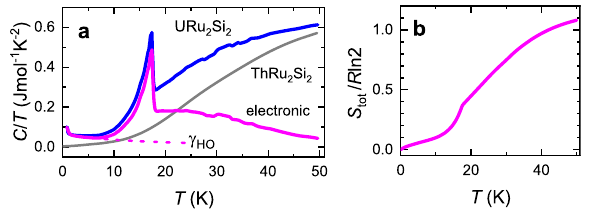
Fig. 2 Heat capacity and entropy of URu 2 Si 2 . a C / T at B = 0 from ref. 57 (blue line), with the phonon (i.e., ThRu 2 Si 2 in gray) component and the total electronic contribution (magenta curve) indicated. γ HO is the residual electronic contribution within the hidden-order phase (see Methods). b Total entropy obtained from S tot ¼